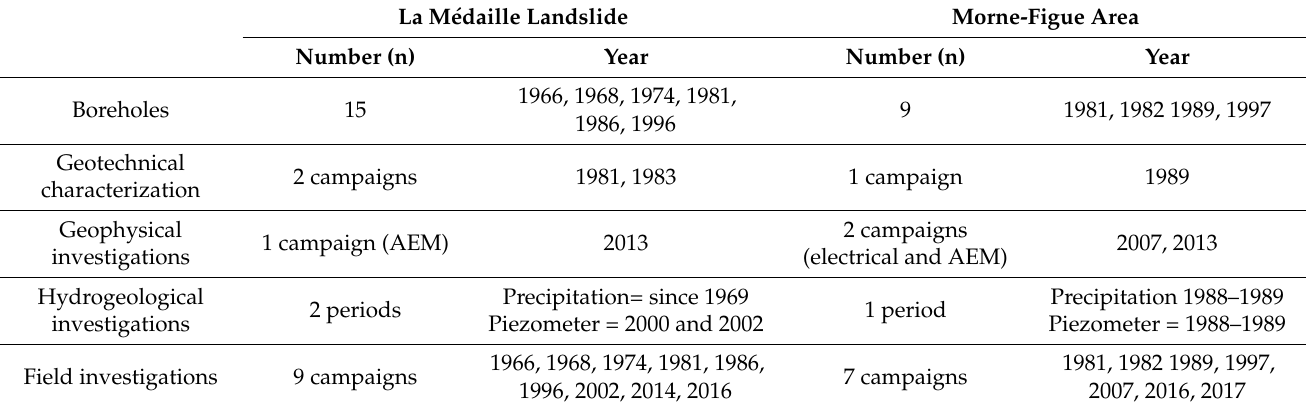
Table 1. Investigations and monitoring of the two sites since the